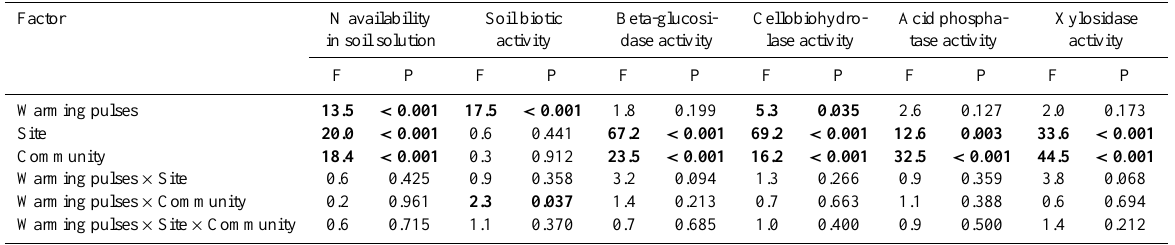
Table 2. ANOVA results of all tested main and interaction effects for N mobilization, i.e. N availability in the soil solution (NH + soil biotic activity (bait-lamina test), and the four tested potential soil enzyme activities. Warming pulses: winter warming pulses treatment.